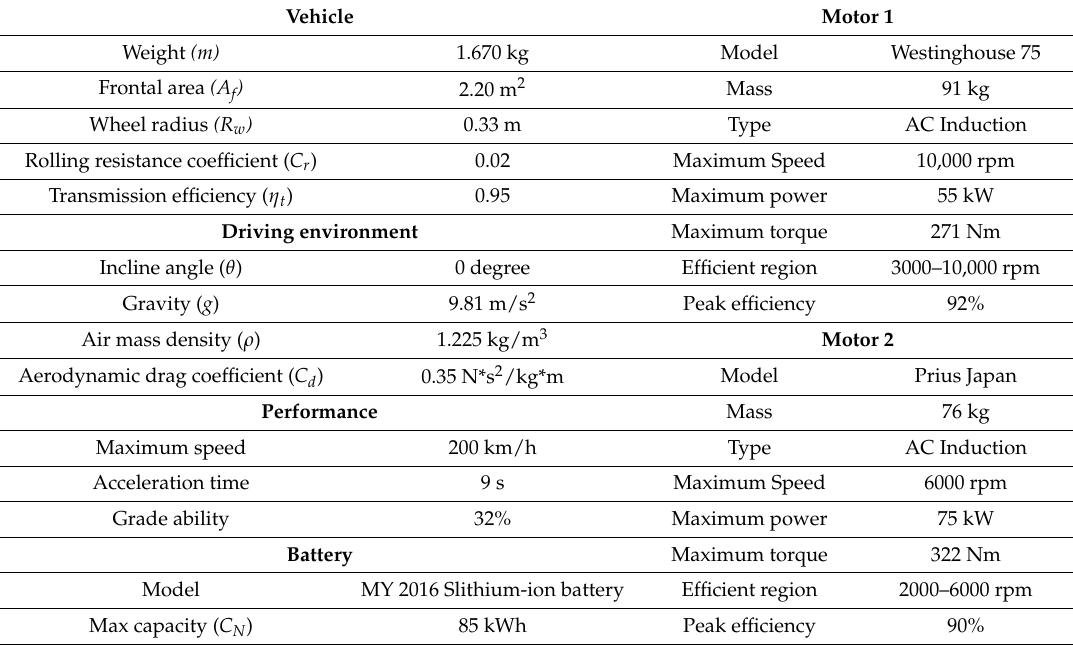
Table 2. The system specifications.